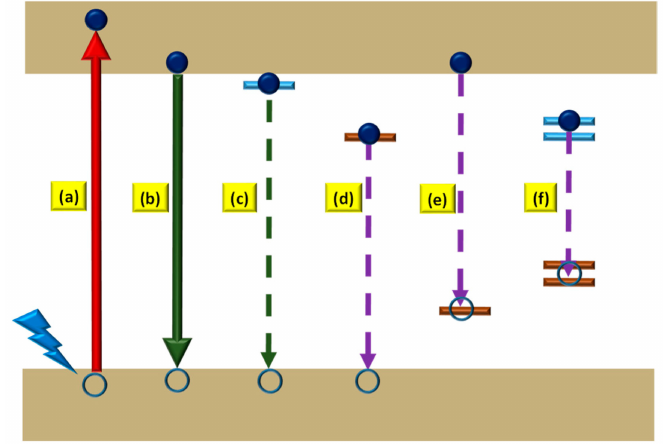
Figure 2. The possible emission mechanism for ( a ) light absorption, ( b ) band-to-band emission, ( c ) ex- citon emission, ( d ) emission from defects, ( e ) emission from ions, ( f ) self-trap exciton (STE)